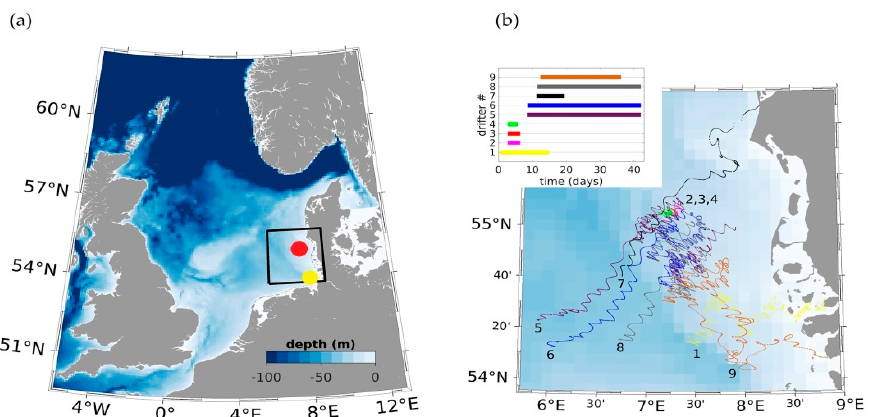
Figure 1. ( a ) The North Sea (depth in m) topography as used for the model simulations and buoy locations (red circle: Fino3, yellow circle: Elbe). ( b ) Magnification of the German Bight showing the HZG drifter trajectories released at the location of their respective numbers. Deployment periods of the HZG drifters are shown on the top left corner.